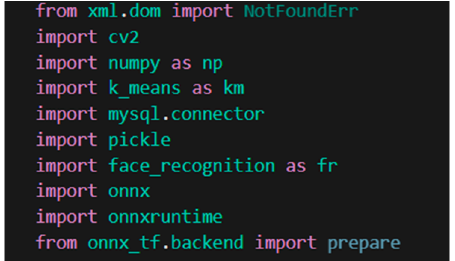
Figure 5. Python libraries used.